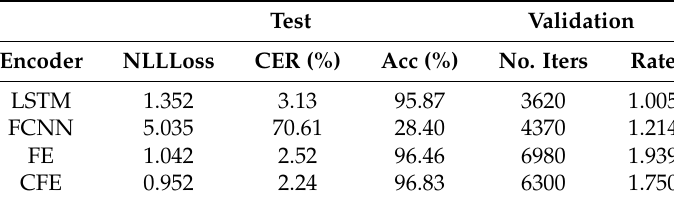
Table 4. Results obtained by the four models for the first experiment (E1). Encoder: Name of the encoder used. NLLLoss: Negative log-likelihood loss. CER: Character error rate. Acc (%): Accuracy. No. iters: Number of iterations. Rate: Iterations per second.